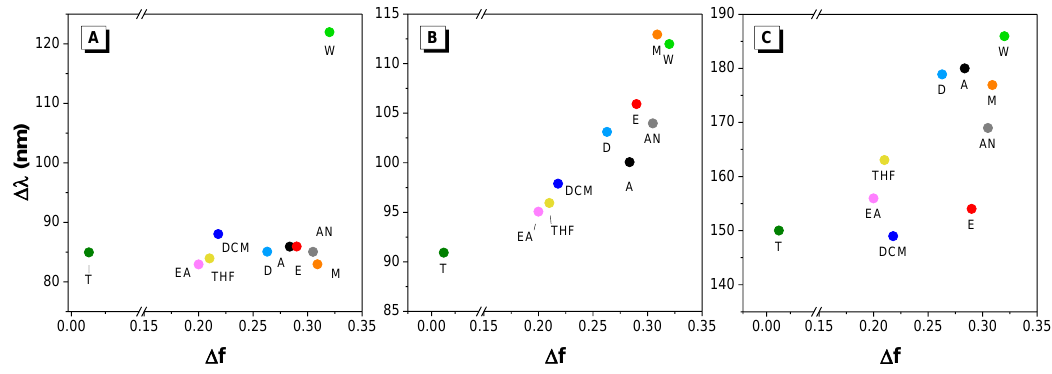
Figure 5. Lippert – Mataga solvatochromism plot of dyes 1 ( A ), 2 ( B ) and 3 ( C ) in different solvents as a function of solvent polarity measured by Lippert-Mataga polarity parameter. A = acetone, AN = acetonitrile, D = DMSO, E = ethanol, EA = ethyl acetate, M = methanol, T = toluene, W = water.